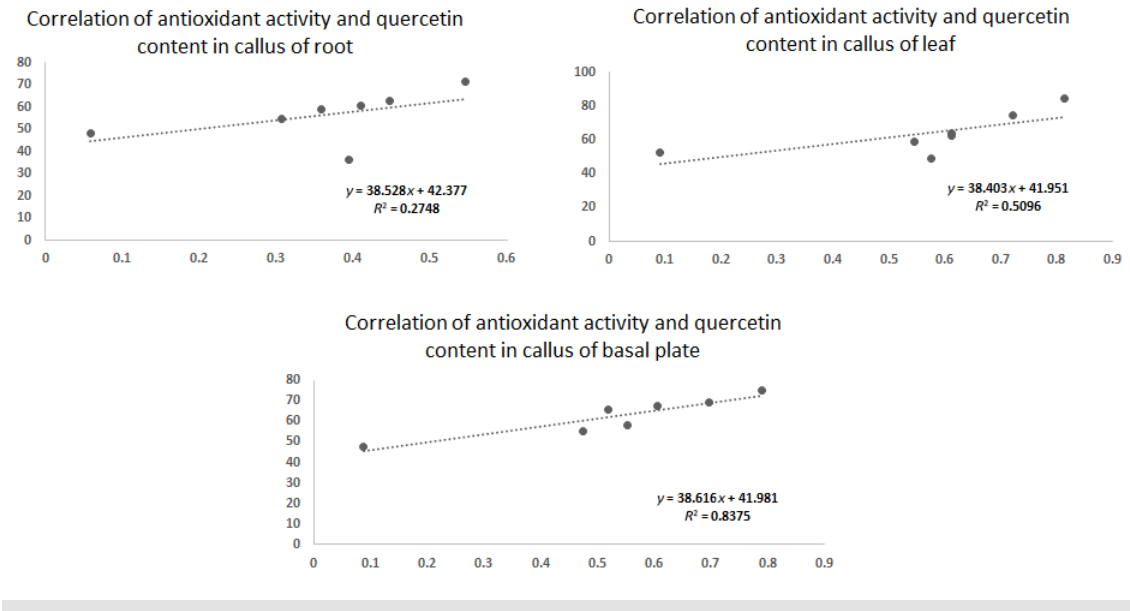
Fig. 7 Regression analyses of total antioxidant activity and quercetin content in callus cultures of A. cepa